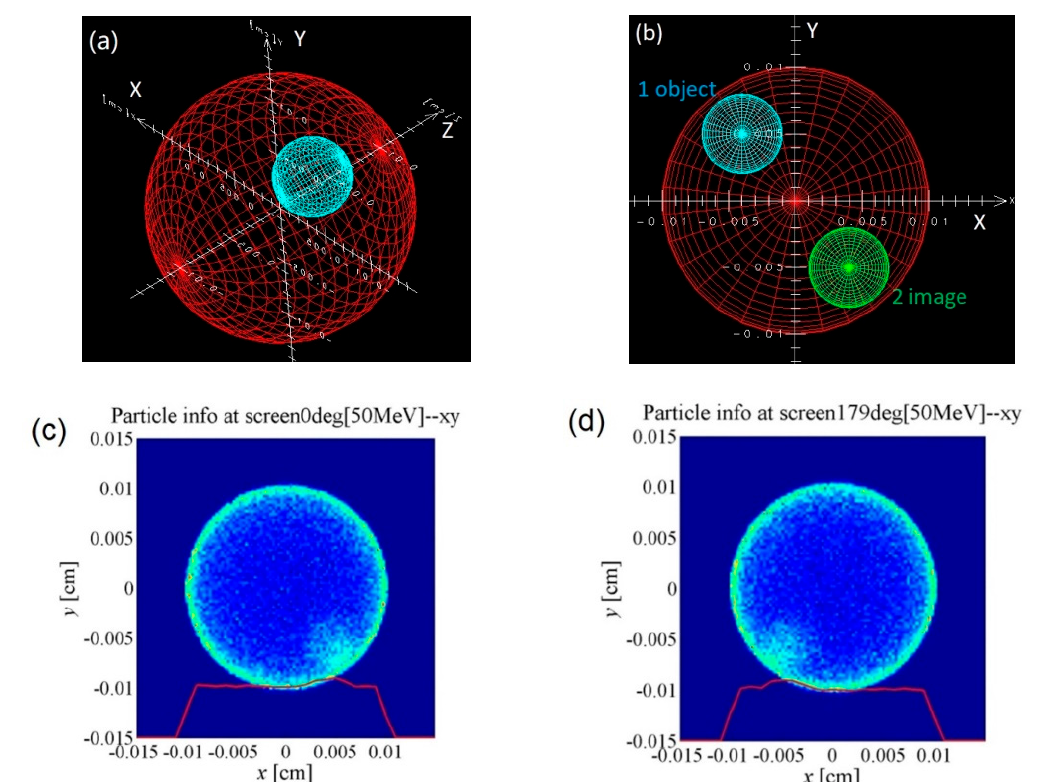
total number of slices are 0.03 cm and 100, respectively. Therefore, the thickness of each slice is 3 µ m. The inner ball in each slice image along the three axes is shown from invisibility to visibility, and then to invisibility again, by which the inner ball center position of each axis is determined, shown in Table 3. The errors of the inner ball center positions are due to the slice number uncertainty of the first and last slice images with the inner ball. The reconstruction results are consistent with the original settings in the simulation, and they confirm the validation of the TDHEER, from which the internal structure of the samples can be exactly determined.